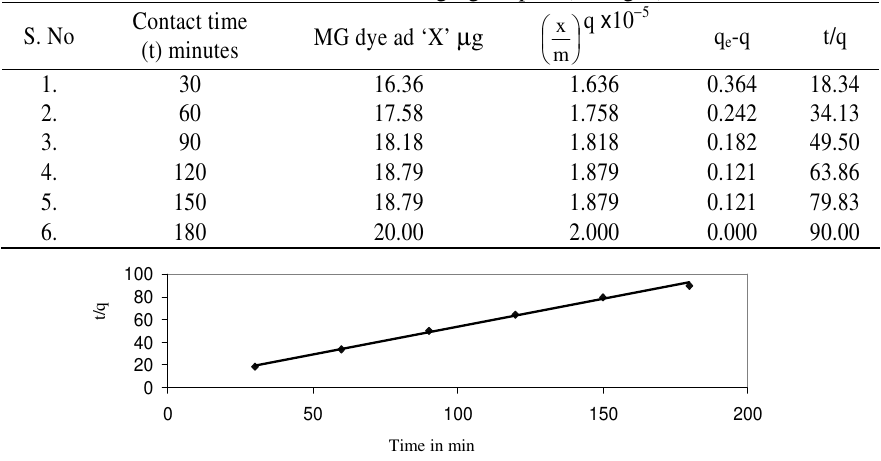
Table 7. Data for Lagergren plot (20 mg/L)